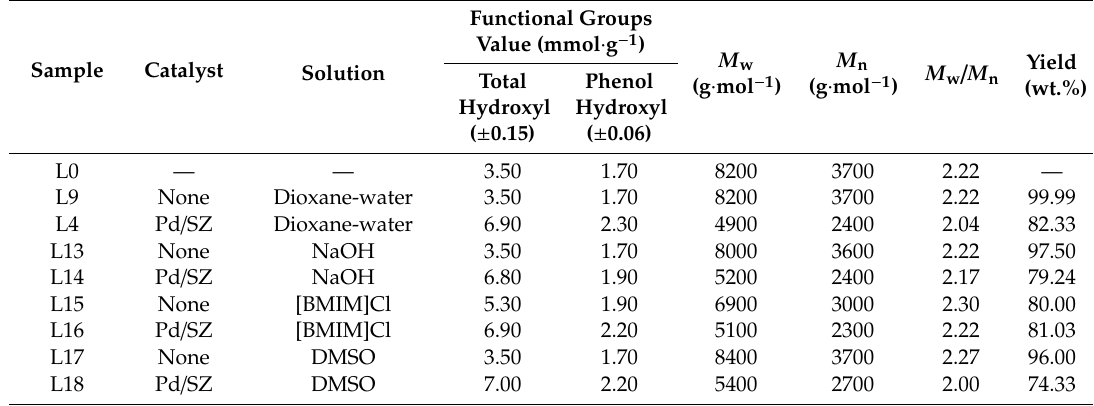
Table 1. The e ff ects of solutions on the